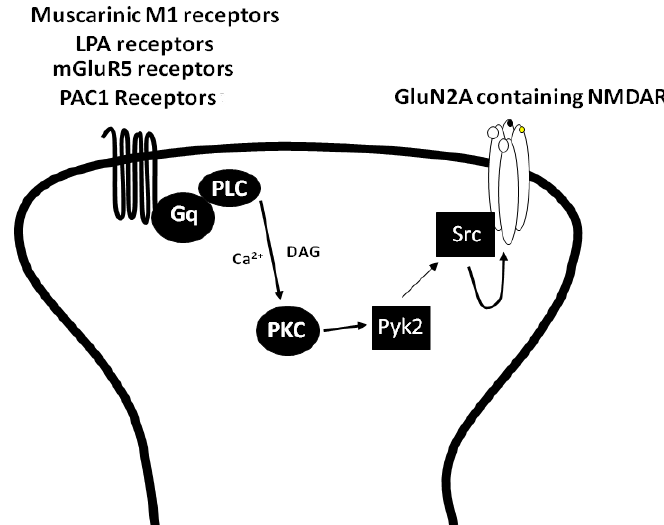
Figure 1. The activation of Gαq coupled receptors induces PLC/PKC/Pyk2/Src signalling to enhance GluN2A containing NMDAR